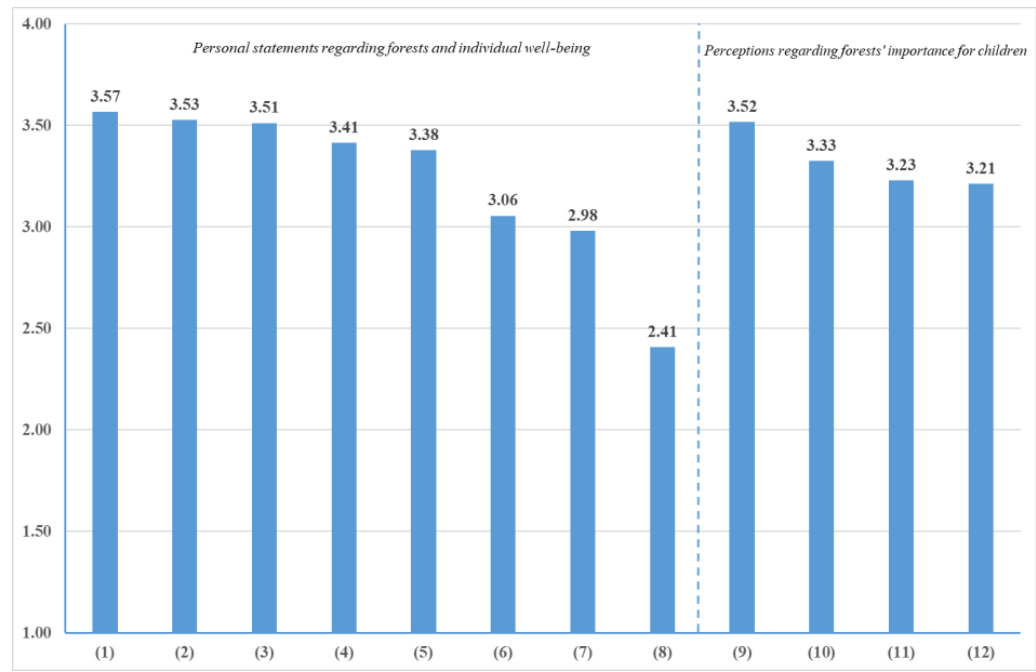
Figure 4. Agreement with personal statements and perceptions regarding forests. The items read: (1) Austrian forests are crucial for Austria’s image; (2) Forests are vital for the natural heritage of Austria; (3) Typical forests contribute to Austria's identity; (4) Forests are vital for the cultural heritage of Austria; (5) Forestry is of high importance for the management of forests and for providing renewable energy sources; (6) Preferences for staying in natural forests (wilderness); (7) Regular activities in forests (1–2 times per month) are critical for my personal well-being; (8) Forests are closely related to melancholy and solitude; (9) Kids’ visits to forests teach them to responsibly care for nature; (10) Importance of children’s playing in forests for their educational achievements; (11) Kids fully develop their creativity in forests; and (12) Visiting forests are decisive for childhood